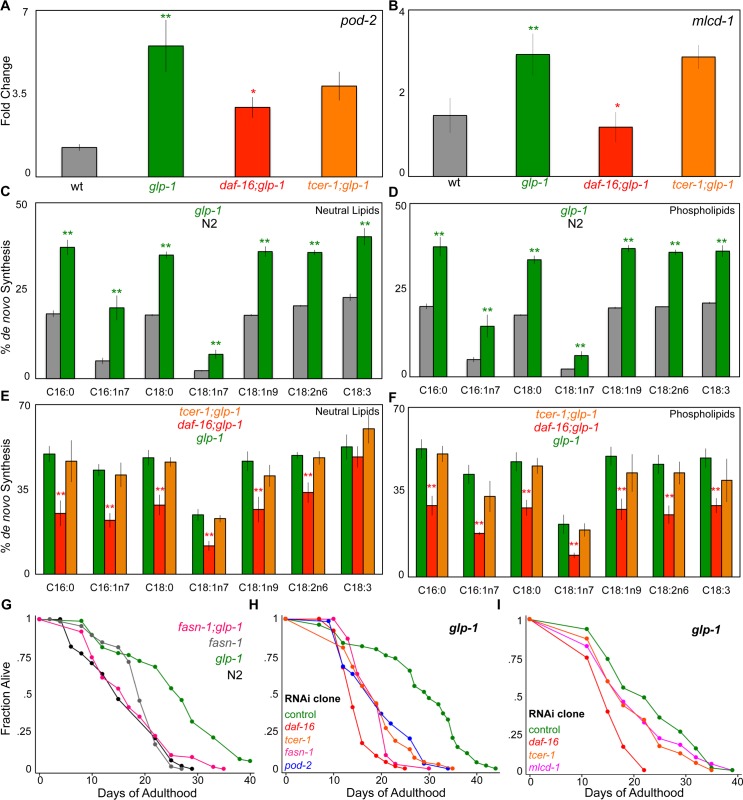
de novo fatty-acid synthesis is elevated following germline loss by DAF-16.A, B. DAF-16 mediates increased expression of pod-2 and mlcd-1 at least in part in germline-less adults. mRNA levels of pod-2 (A) and mlcd-1 (B) compared between wild-type (N2, gray), glp-1 (green), daf-16;glp-1 (red) and tcer-1;glp-1 (orange) day 2 adults by Q-PCR. C-F. Germline loss causes increased de novo lipid synthesis in a daf-16-dependent manner. C, D.
de novo fatty acid synthesis and dietary fat absorption and compared using a 13C isotope fatty-acid labeling assay [45] between late L4/early day 1 adults of wild type (N2, gray bars) and glp-1 (green) strains. de novo lipid synthesis is significantly increased in both neutral lipid (C) and phospholipid (D) fractions of glp-1 mutants. E, F. Day 2 adults of the sterile strains, glp-1 (green), daf-16;glp-1 (red) and tcer-1;glp-1 (orange), were assessed through the same assay. In both neutral lipids (E) and phospholipids (F), de novo lipid synthesis is substantially reduced in daf-16;glp-1 mutants, but not tcer-1;glp-1 mutants, as predicted by RNA-Seq and Q-PCR. G-I. Knockdown of de novo fatty-acid synthesis genes impairs the longevity of glp-1 adults. G. Effect of fasn-1 mutation on the lifespan of glp-1 mutants and wild-type (N2) worms. glp-1 (green; m = 26.5 ± 0.5, n = 76/85), fasn-1;glp-1 (pink; m = 18.0 ± 0.8, n = 84/88; P vs. glp-1 <0.0001), N2 (black; m = 16.7 ± 0.7, n = 76/91), fasn-1 (gray; m = 19.1 ± 0.6, n = 62/75; P vs. N2 <0.0001). H, I. Effect of RNAi knockdown of pod-2, fasn-1 (H) and mlcd-1 (I) on the lifespan of glp-1 mutants. glp-1 mutants were subjected to RNAi during adulthood by feeding bacteria containing empty control vector (green) as well as bacteria expressing dsRNA targeting different genes. In H: control (green; m = 27.9 ± 1.3, n = 49/50), daf-16 (red; m = 14.8 ± 0.3, n = 74/78; P vs. control <0.0001), tcer-1 (orange; m = 19.0 ± 0.6, n = 76/78; P vs. control <0.0001), pod-2 (blue, m = 19.8 ± 0.8, n = 61/63, P vs. control, <0.0001) and fasn-1 (pink, m = 18.5 ± 0.4, n = 69/72, P vs. control, <0.0001). In I: control (green; m = 23.3 ± 0.8, n = 77/91), daf-16 (red; m = 15.7 ± 0.3, n = 83/110; P vs. control <0.0001), tcer-1 (orange; m = 20.0 ± 0.7, n = 75/85; P vs. control <0.0001), mlcd-1 (pink; m = 20.6 ± 1.1, n = 53/75, P vs. control, 0.05). In A-F, asterisks represent the statistical significance of differences observed in an unpaired, two-tailed t-test with P values 0.05 (*), 0.005 (**) or < 0.0005 (***). Green asterisks indicate the comparison between N2 and glp-1, whereas, red and orange asterisks depict the comparisons between glp-1 and daf-16;glp-1 or tcer-1;glp-1, respectively. Error bars represent the standard error of the mean. Data from additional trials is shown in S6 (G) and S7H and S7I Tables.